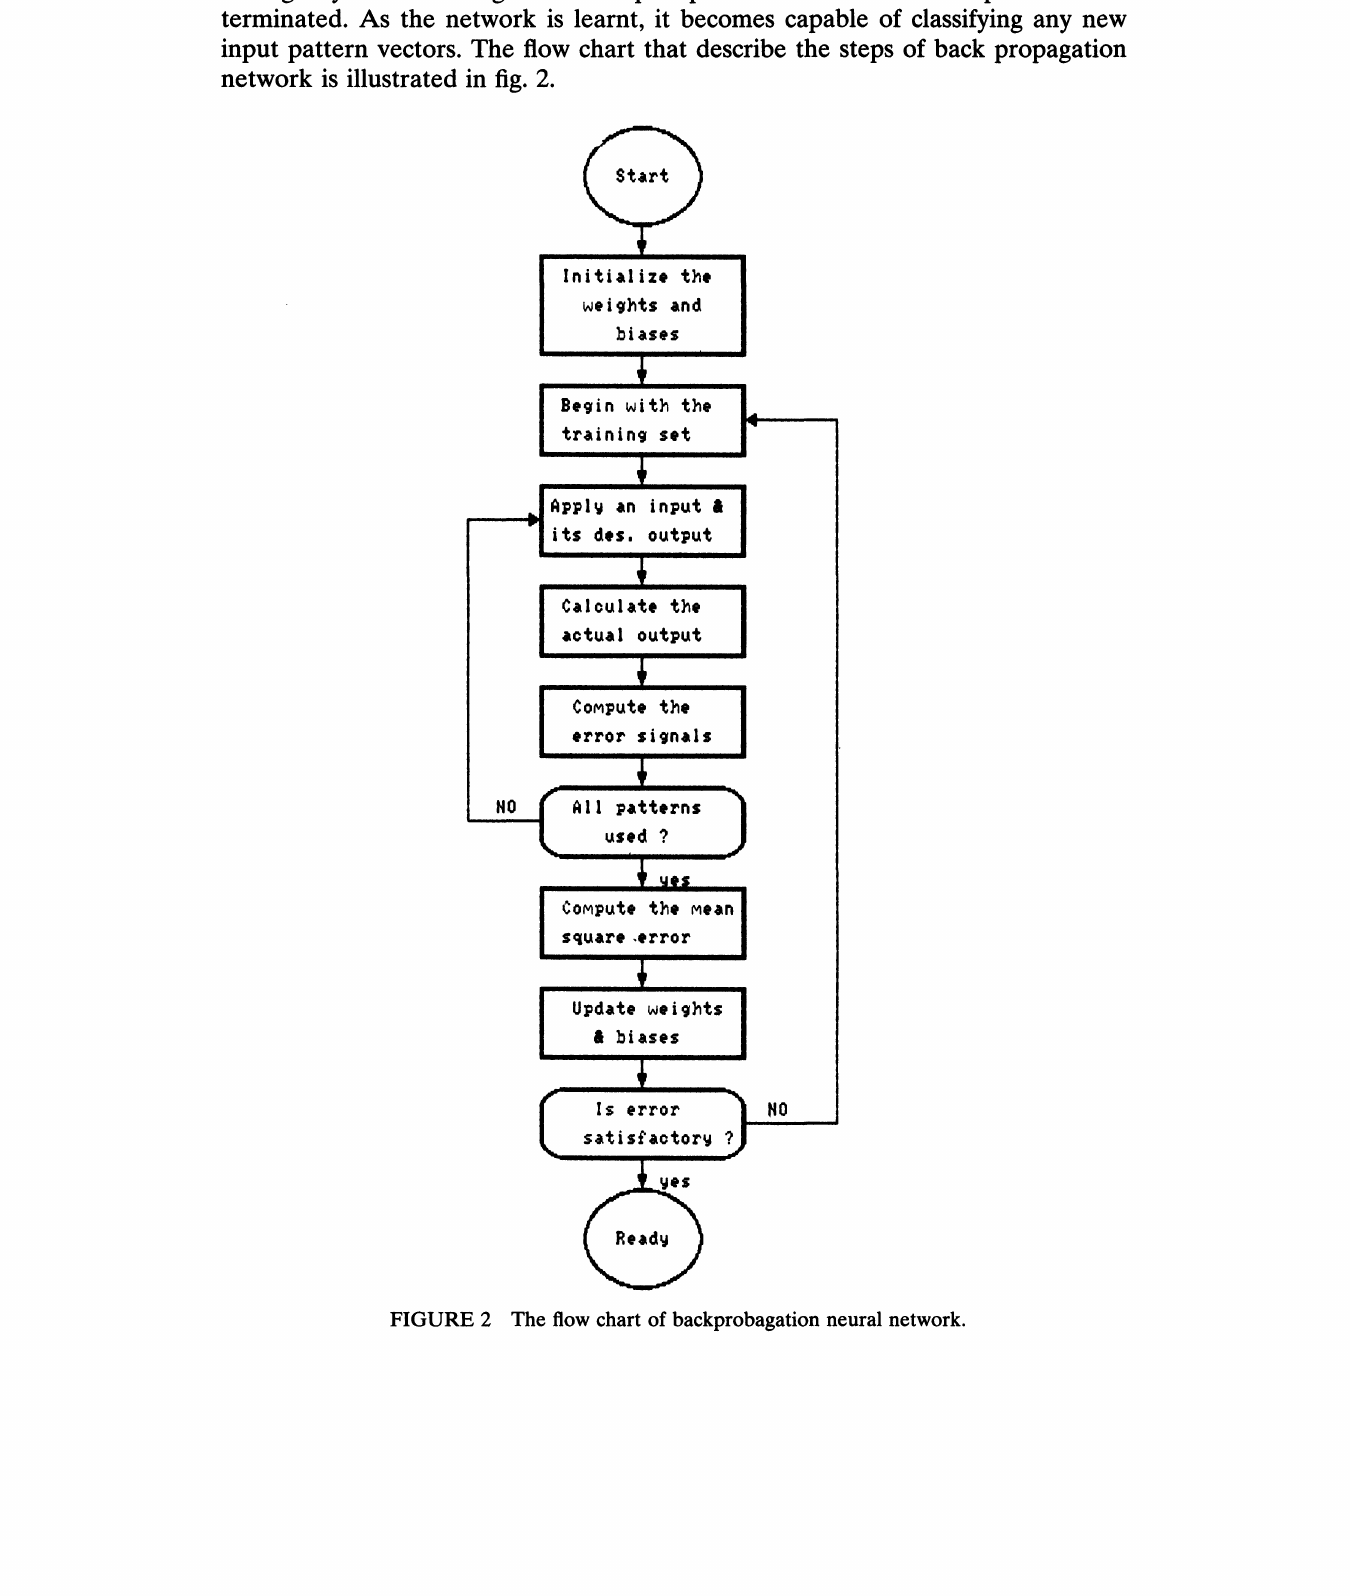
FIGURE 2 The flow chart of backprobagation neural